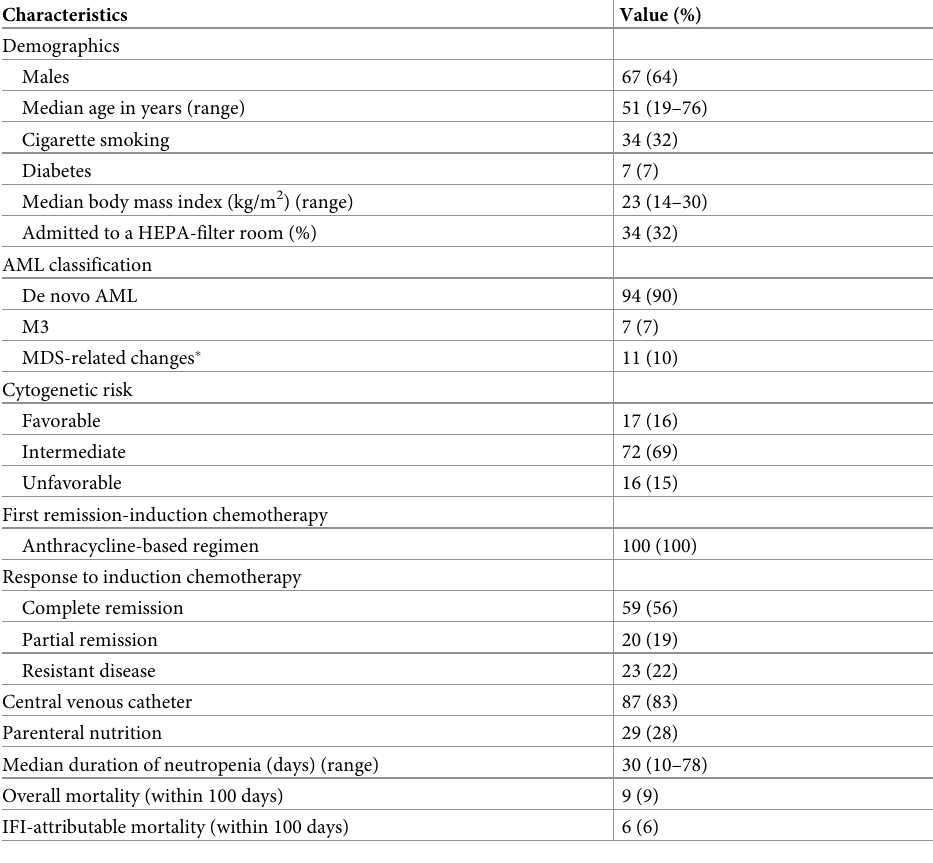
Table 1. Baseline characteristics of 105 Taiwanese patients with newly diagnosed acute myeloid leukemia (AML).